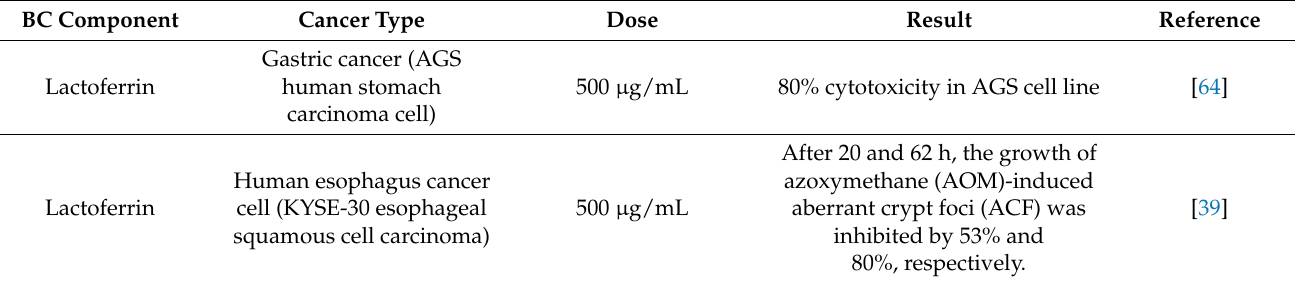
Table 2. Anti-cancer effects of BC constituents on various cancer cell